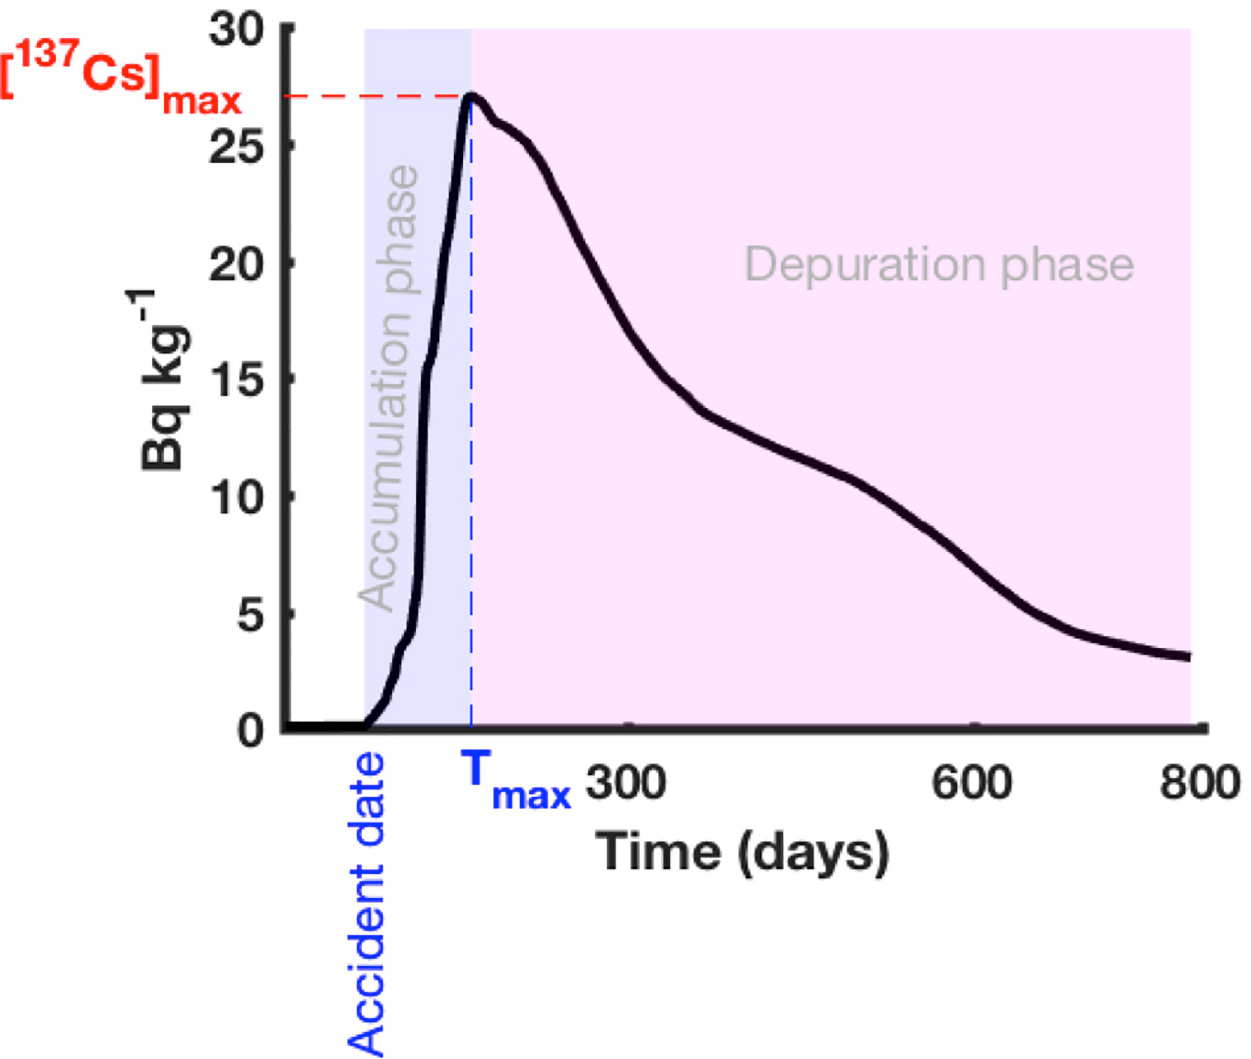
Fig 10. Typical curve of the 137 Cs activity concentration dynamics in the marine organism, illustrating the accumulation and elimination phases as well as the different radioecological metrics.